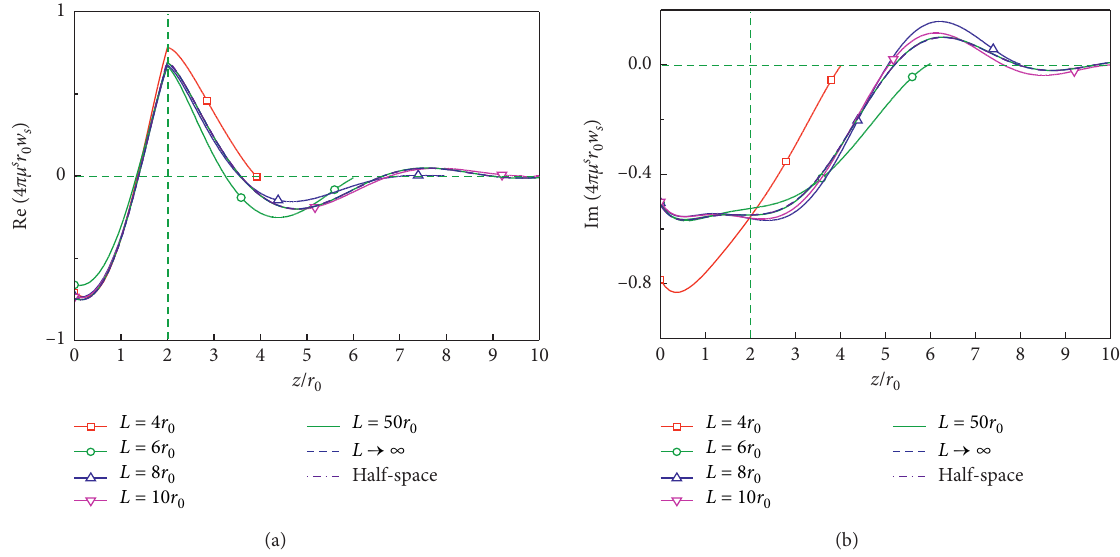
Figure 8: Vertical displacement w part of vertical